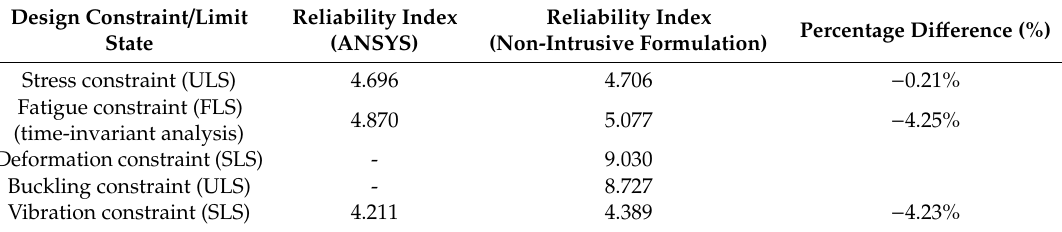
Table 11. Comparison between the reliability index values computed by the two methods.